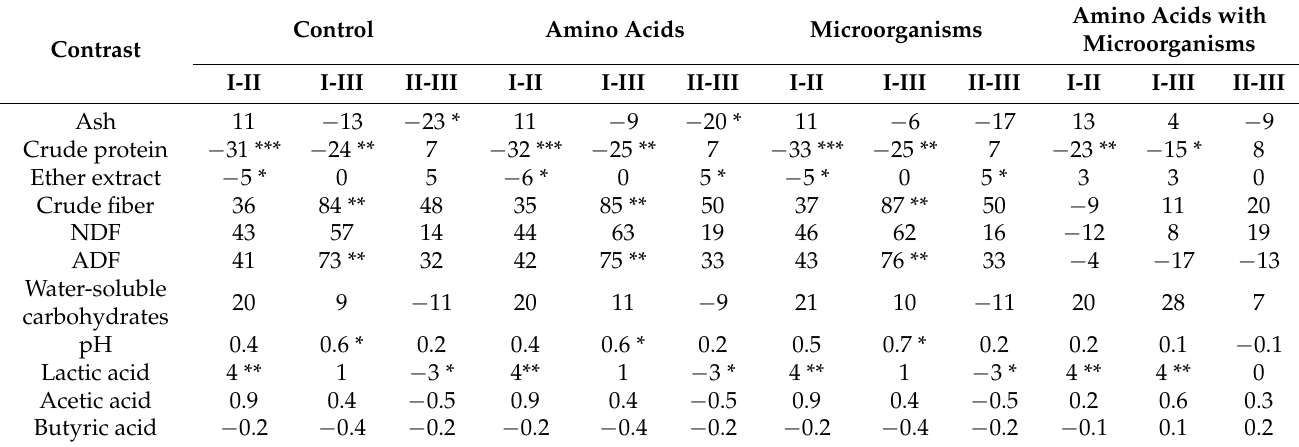
Table 4. Statistical significance of differences between the average values of each pairs of cuts for control, amino acids, microorganisms and amino acids with microorganisms, independently.